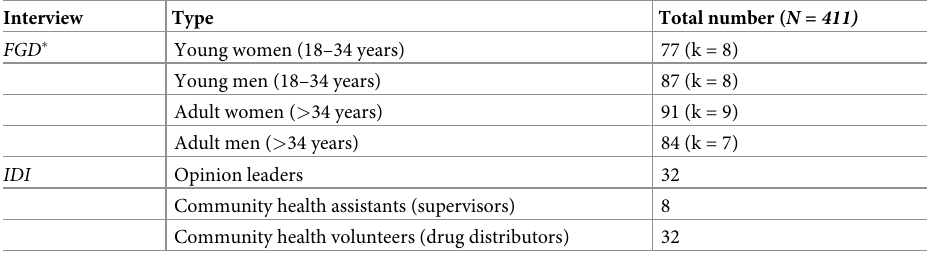
Table 1. Types of interviews conducted and number of participants per